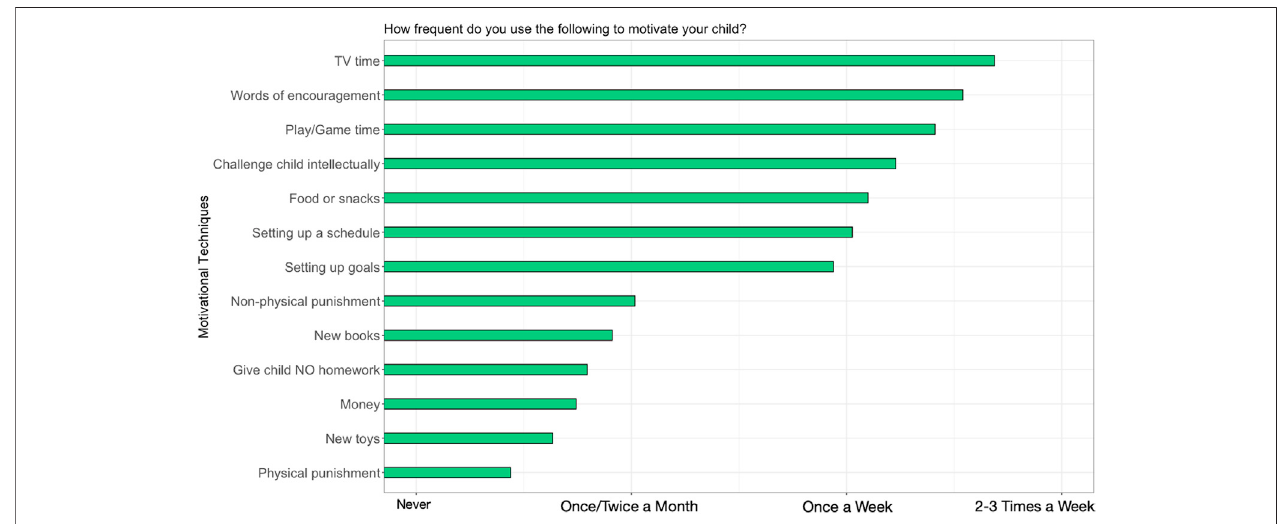
FIGURE 2 | The frequency with which a motivator was used by Indian parents during the